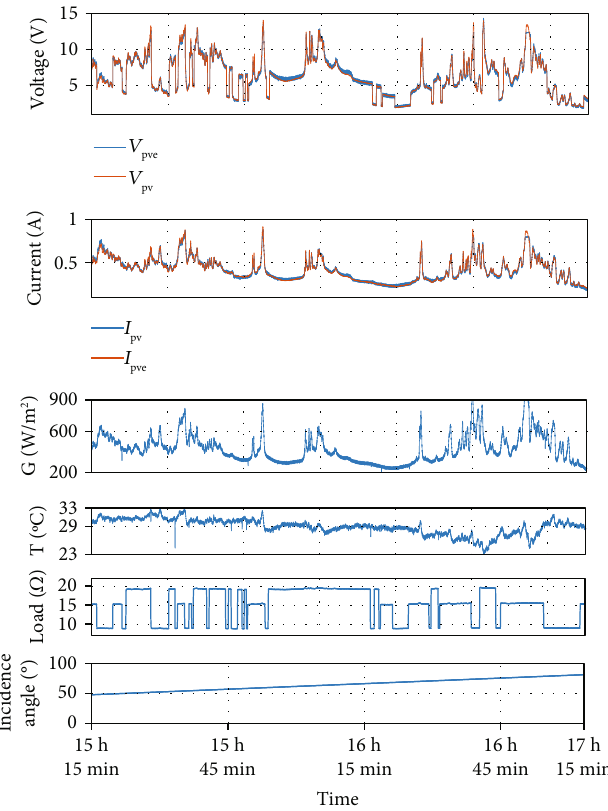
Figure 18: Proposed emulator test under real use conditions with automatic incidence angle